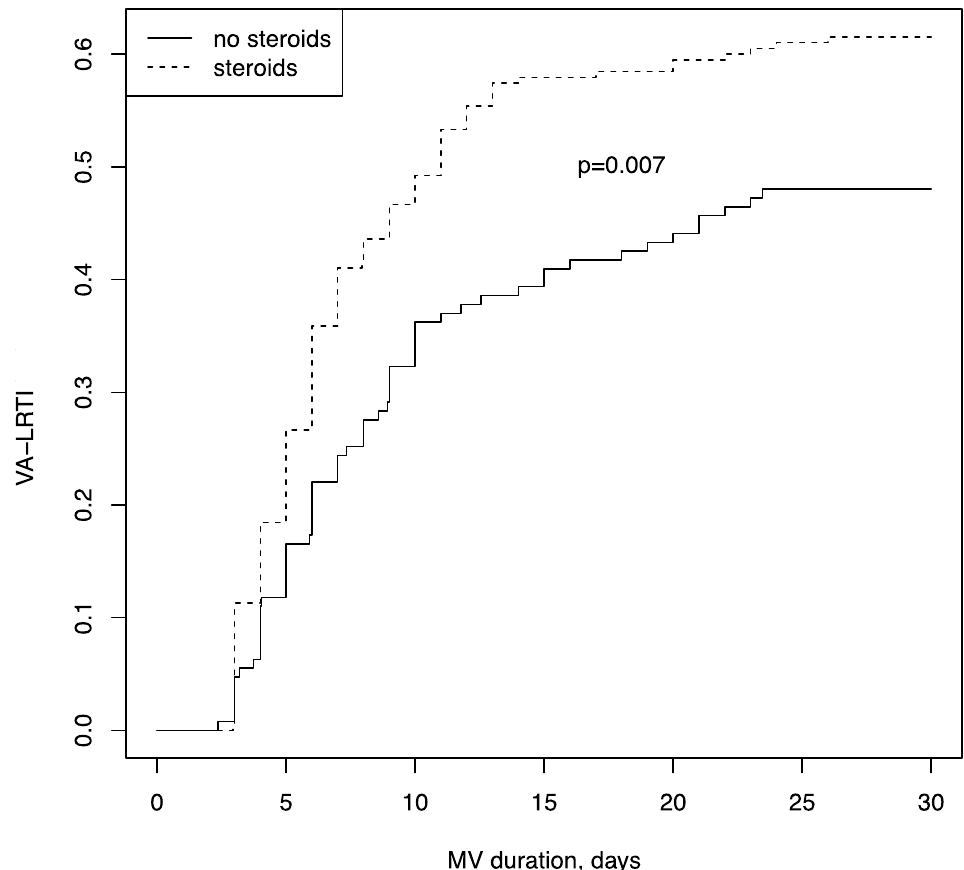
Figure 1. Cumulative incidence of ventilatory-associated lower respiratory tract infection within 30 days of mechanical ventilation, using a Fine and Gray model, considering extubation or death within 30 days as competing events. VA-LRTI: ventilator-associated respiratory tract infection. Multivariable Fine and Gray models were additionally employed to identify factors that were independently associated with VA-LRTI occurrence within the first 30 days of MV, while considering the competing risks of death and extubation. Corticosteroid treat- ment and male gender were both associated with an increased hazard for VA-LRTI (un- adjusted sHR 1.61, [1.17 – 2.02], p = 0.0028, and unadjusted sHR = 1.74 [1.24 – 2.44], p = 0.0013, respectively) (Table 3). This association remained significant after adjusting for confound- ing factors (adjusted sHR = 1.45 [1.05 – 199], p = 0.022 and adjusted sHR = 1.7 [1.21 – 2.39], p = 0.002, respectively). Using multivariable cause-specific hazard models, corticosteroids were associated with significantly decreased hazards of extubation (HR 0.72 [0.53 – 0.98], p = 0.038) and of ICU discharge alive (HR 0.73 [0.53 – 0.99], p = 0.048) (both with mortality considered as a competing event) (Supplementary Material Tables S1 and S2).